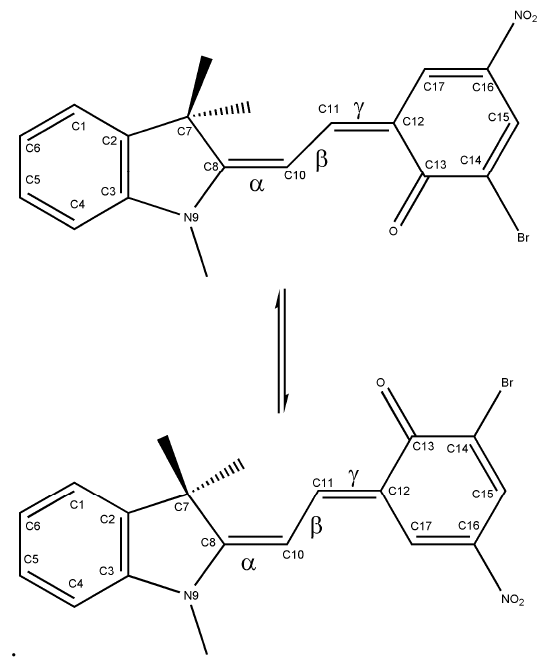
Figure 1 – Atom numbering of the TTC and TTT